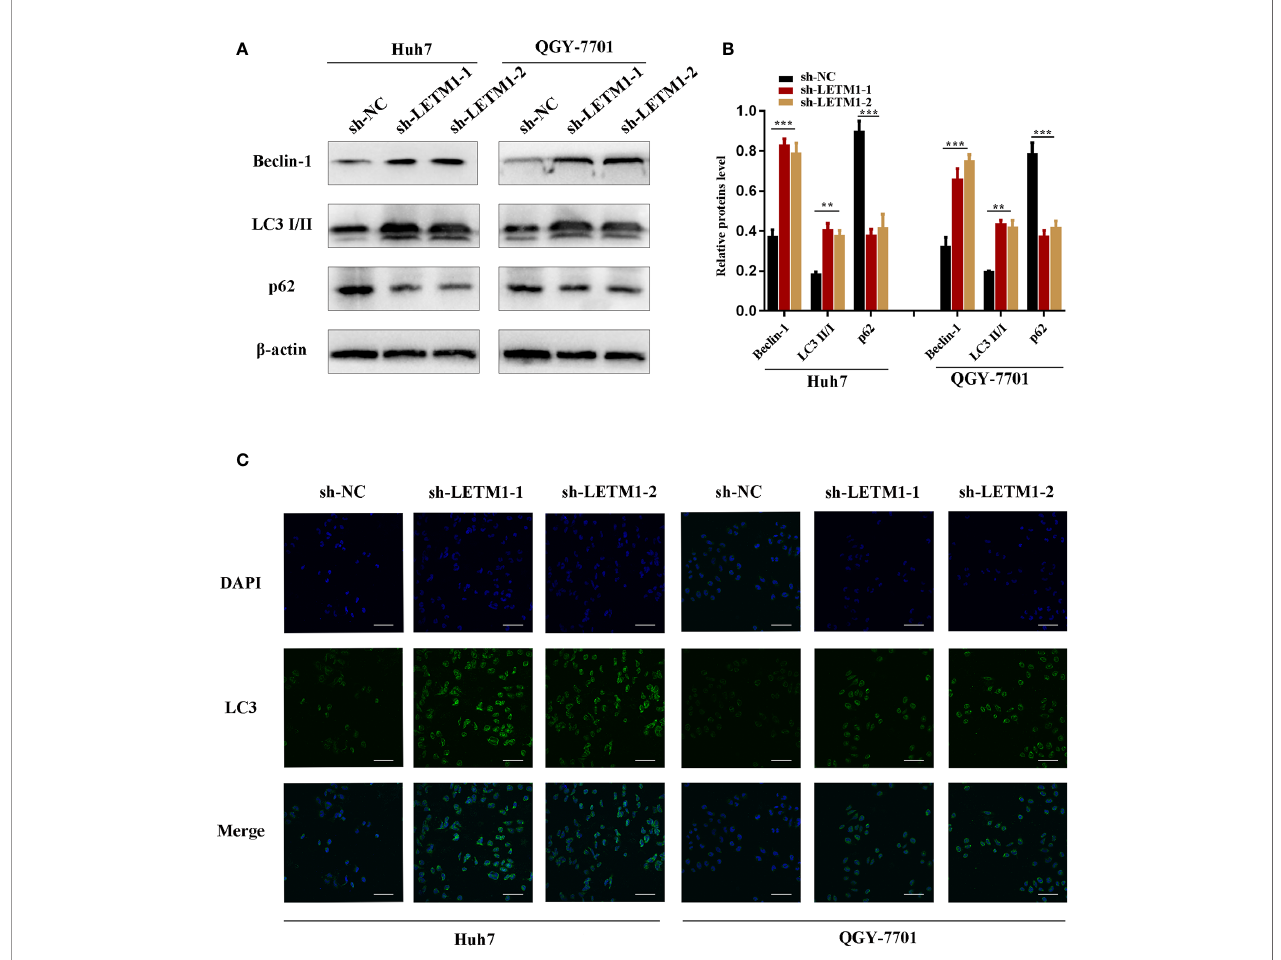
FIGURE 3 | Knockdown of LETM1 triggers autophagy in Huh7 and QGY-7701 cell lines. (A, B) Western blotting of LETM1 and auto-related proteins in LETM1- knockdown Huh7 and QGY-7701 cell lines. (C) Immuno fl uorescence assay of LC3 to re fl ect autophagy level (× 400). **p < 0.01, ***p <